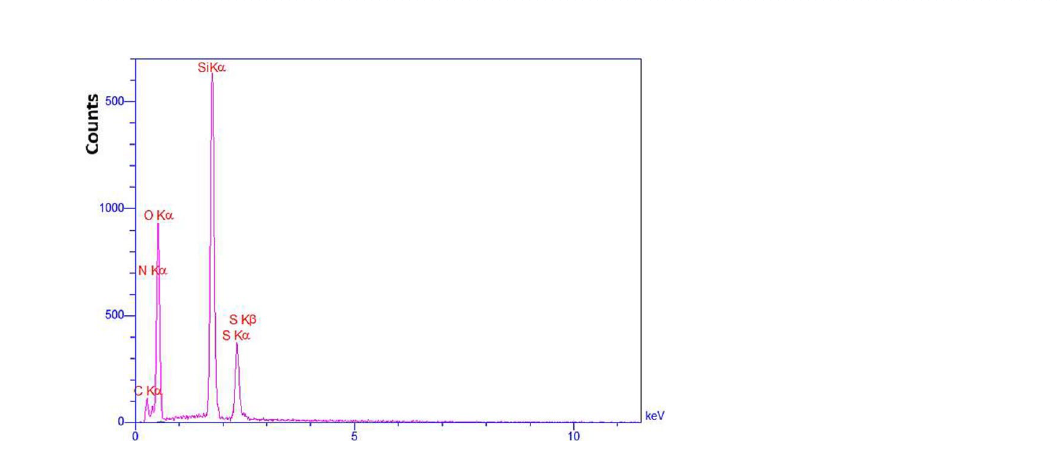
Figure 4. EDX spectra of the MCM-41-APS-PMDA-NHSO 3 H materials ( 1